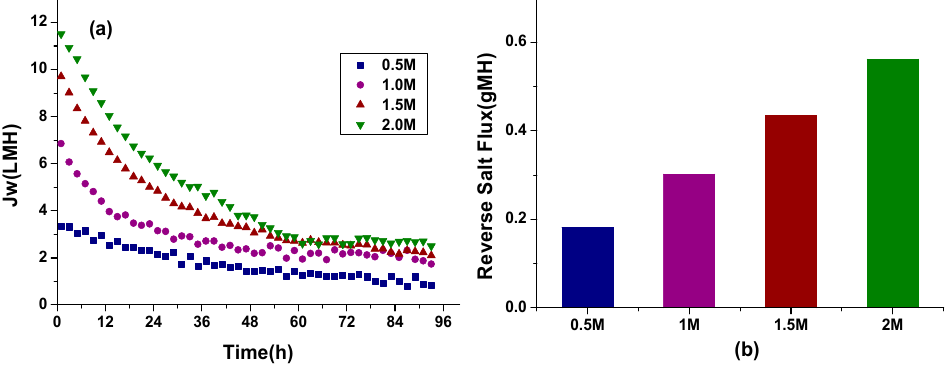
Figure 5. ( a ) Water flux of different DS concentrations in the MF ‐ FDFO ‐ MBR hybrid system; and ( b ) RSF of different DS concentrations in the MF ‐ FDFO ‐ MBR hybrid system (DS: SOA; Feed solution: Synthetic wastewater; Flow rate: 200 mL/min; Temperature: 22 ± 0.5 °C).